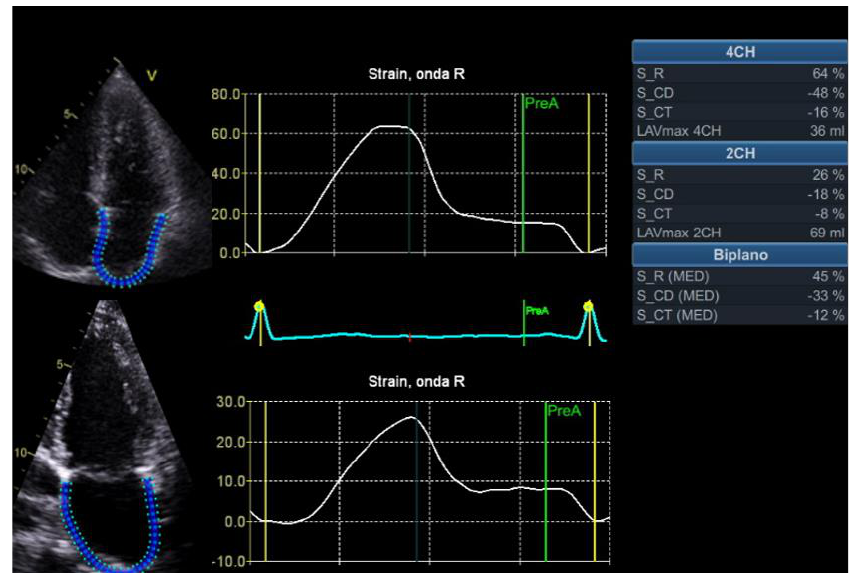
Fig. 2 Example calculation of LA strain, with corresponding LA contractile, conduit and reservoir functions, respectively. LA indicates left atrium.